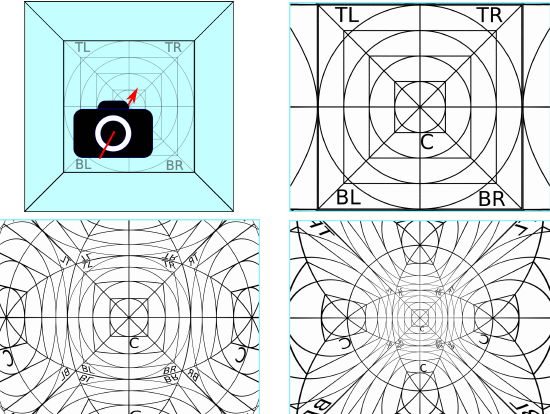
Figure 7: Illustration of Simulation; The top left image illus- trates the camera placement. The top right image is the undis- torted camera image. The lower row contains a Fisheye image (left) and a Catadioptric image (right) For each camera, different positions were sampled at: (0 , 0 , 0) (cid:62) , the position to be compared to; (10 , 0 , 0) (cid:62) , a small baseline po- sition, looking to negative Z axis; (100 , 0 , 0) (cid:62) , a larger baseline position looking to negative Z axis; (500 , 500 , − 500) (cid:62) , a wide baseline position, looking to the center of the front cube face, (0 , 0 , − 1000) (cid:62) .